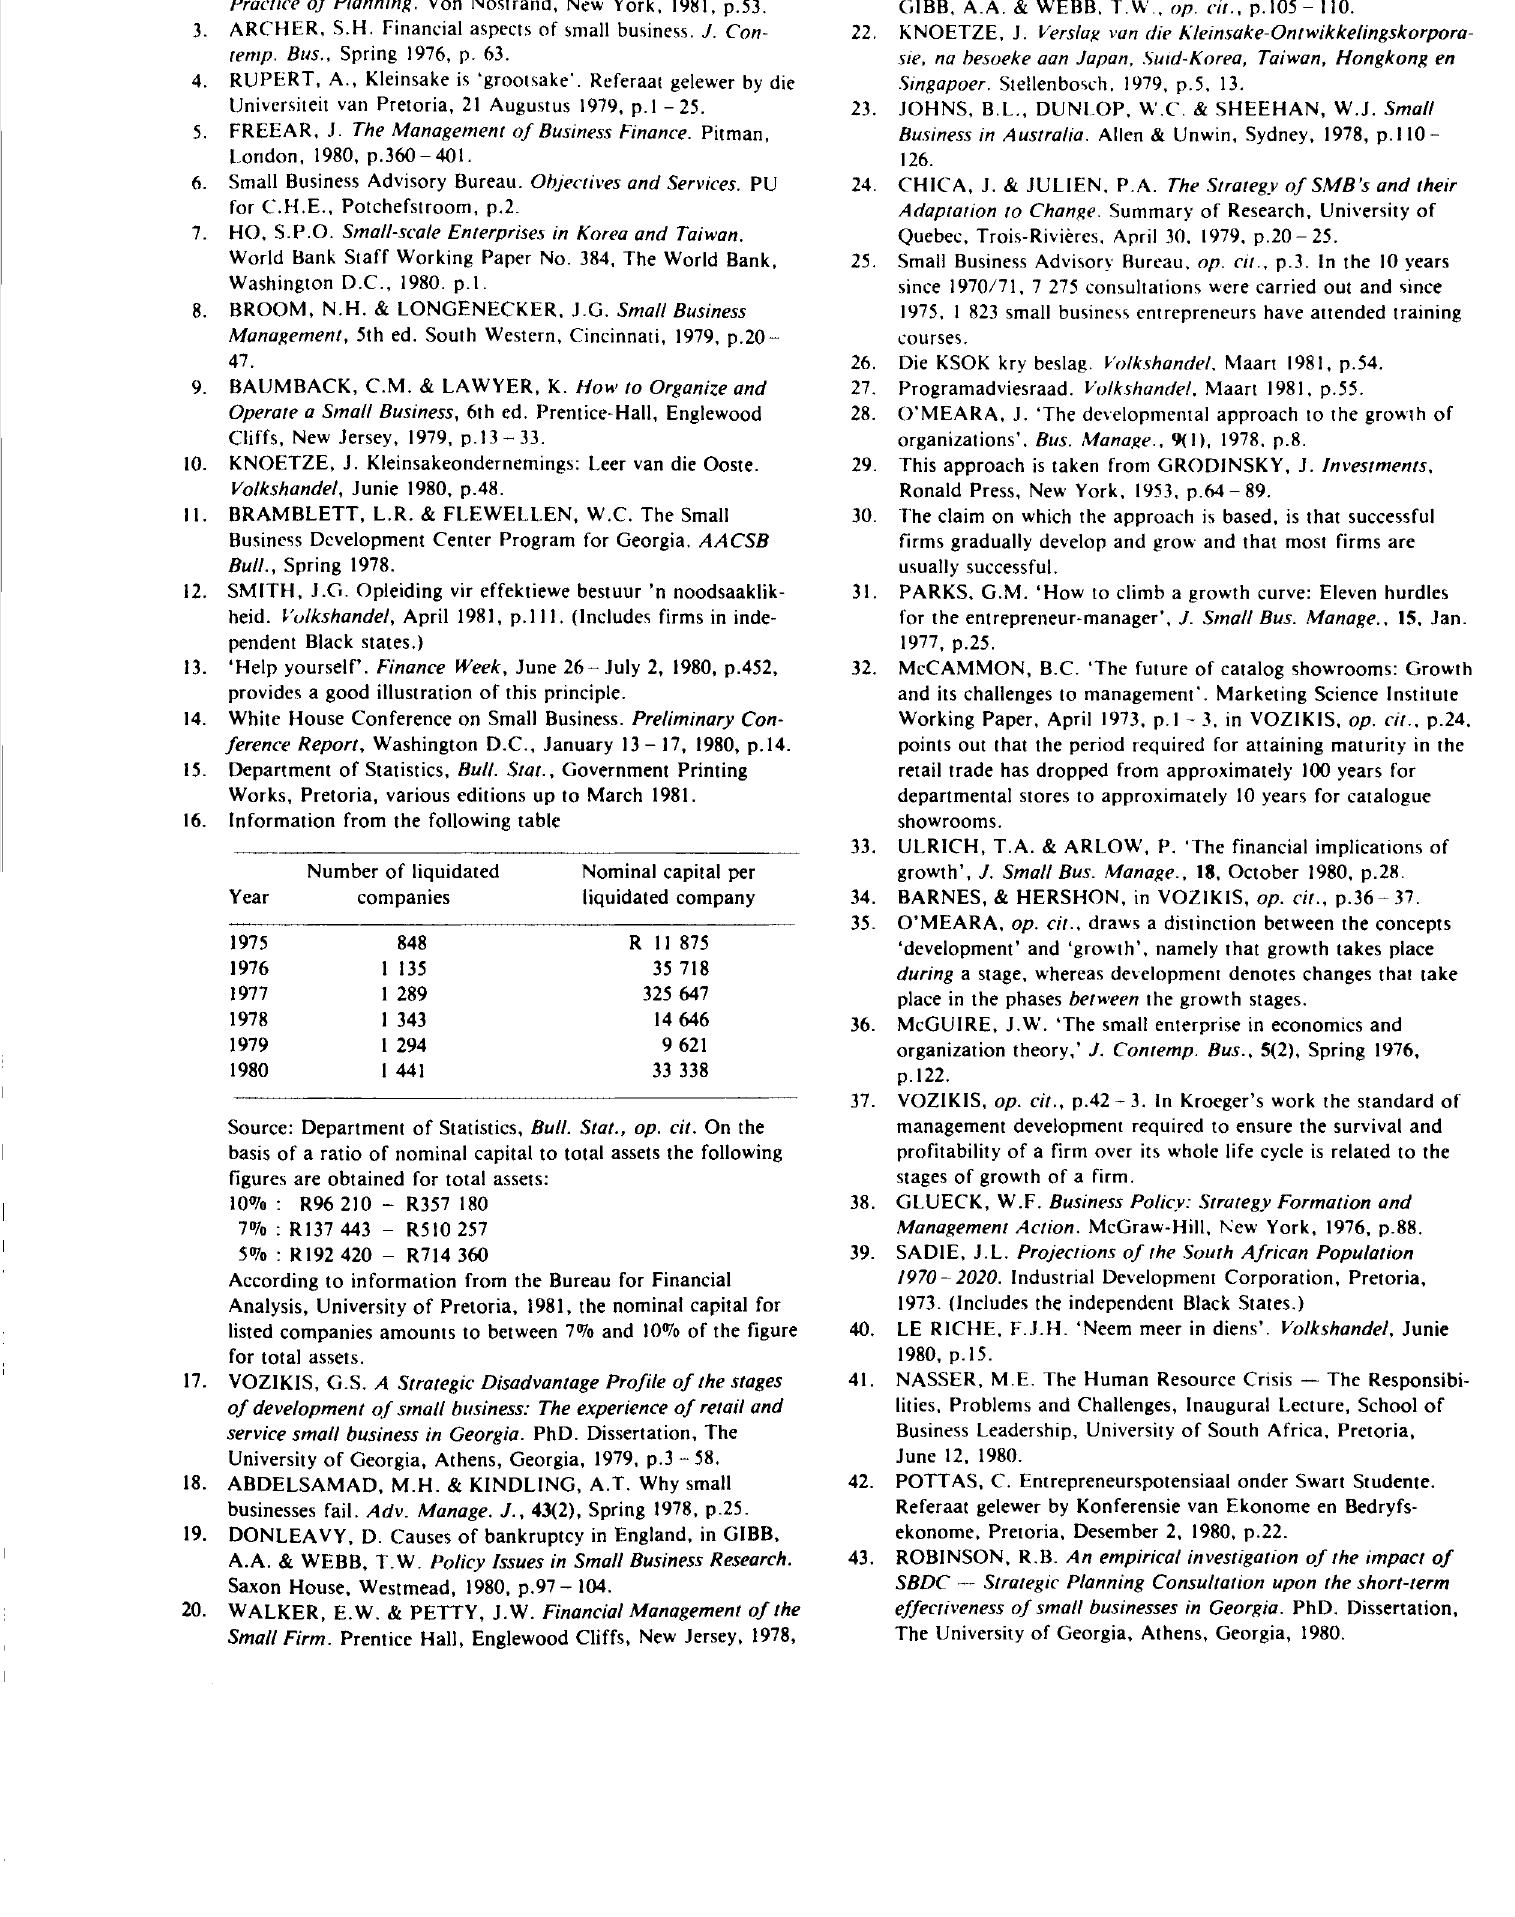
Referaat gelewer by Konferensie van Ekonome en Bedryfs ekonome, Pretoria, Desember 2, 1980,